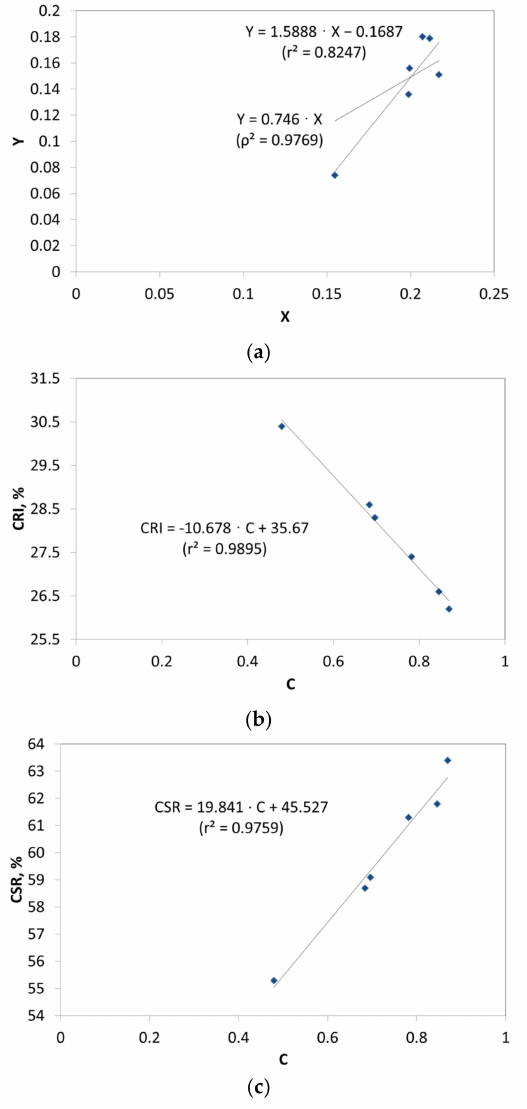
Figure 10. Coke quality parameters dependent on grain distribution constant: ( a ) C for D g = 3 mm grain triangle acc. (14), ( b ) CRI vs C, and ( c ) CSR vs C. The constant C determined at each coordinate shows an effect on the quality of coke, i.e., on CRI (Figure 10b) and CSR (Figure